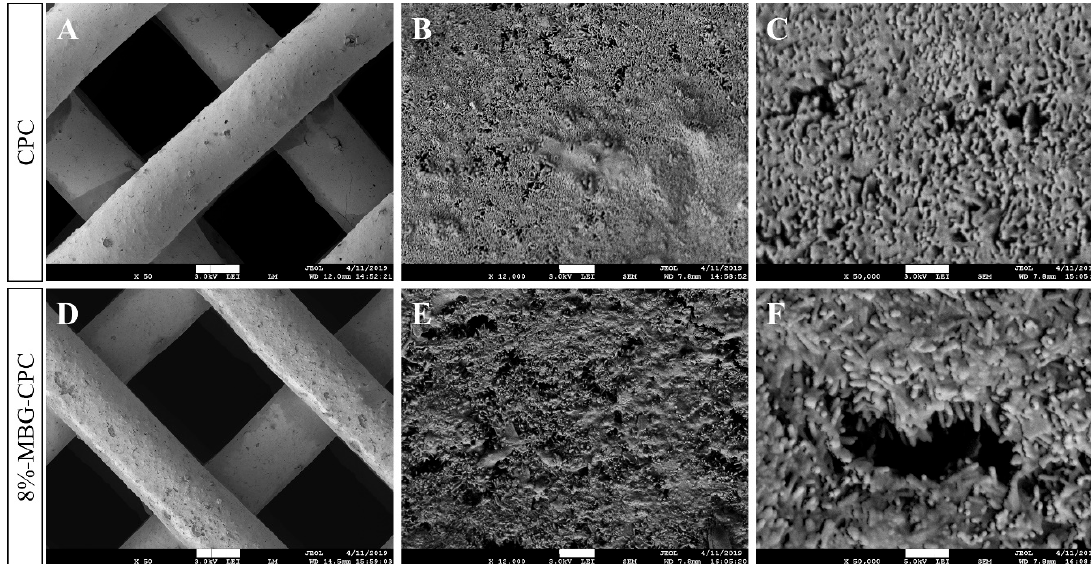
Figure 6. SEM images for 3D plotted scaffolds from unmodified CPC ( A – C ) and an 8%-MBG-CPC composite ( D – F ). The incorporation of MBG led to no distinct changes regarding surface texture or cristallite formation. (scale bars ( A , D ): 300 µm; ( B , E ): 1 µm; ( C , F ): 300